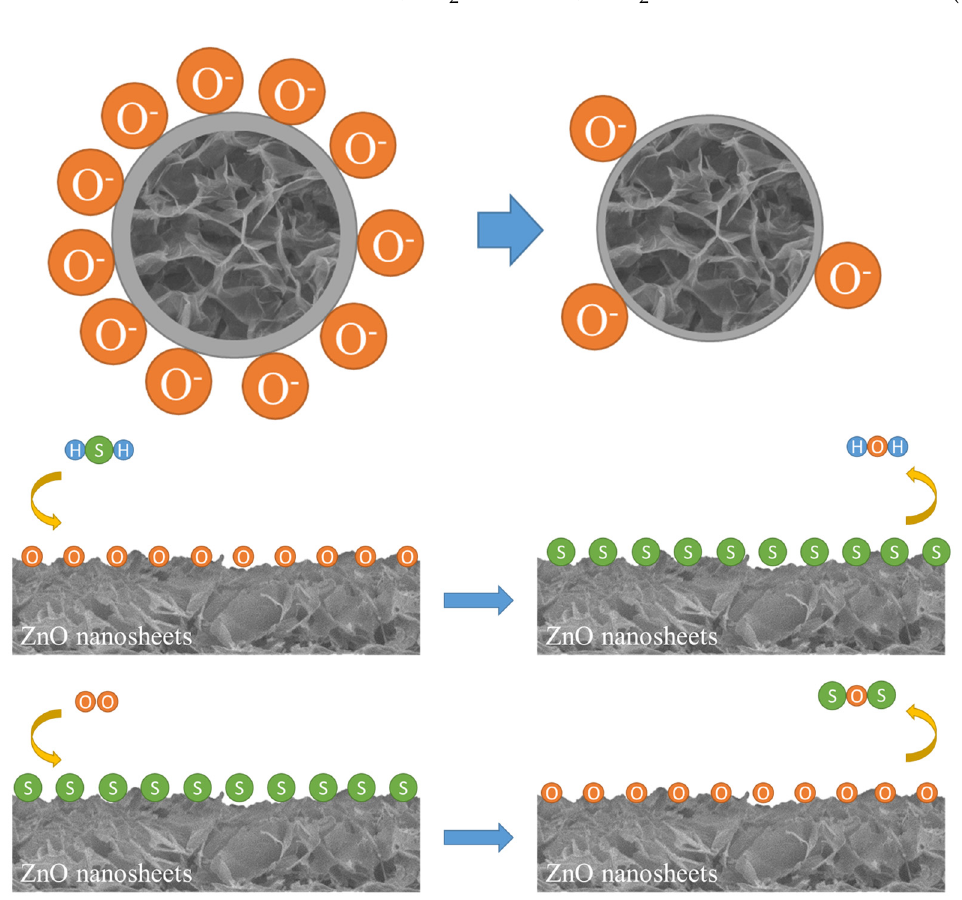
Figure 14. Gas-sensing mechanism of ZnO sensor with H 2 S gas.